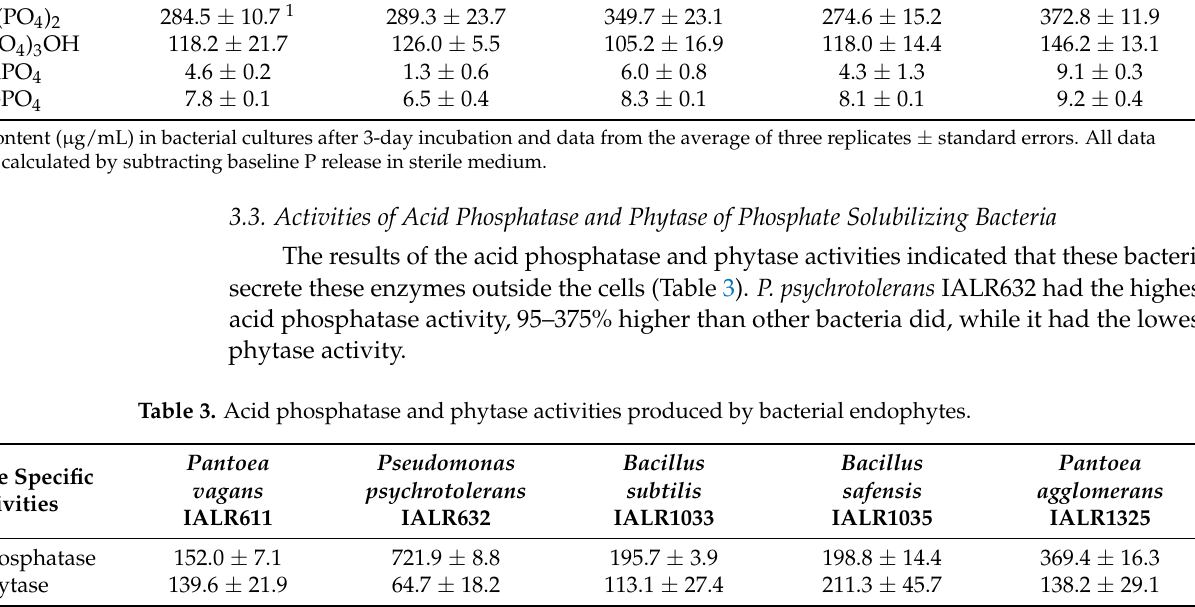
Table 3. Acid phosphatase and phytase activities produced by bacterial endophytes.